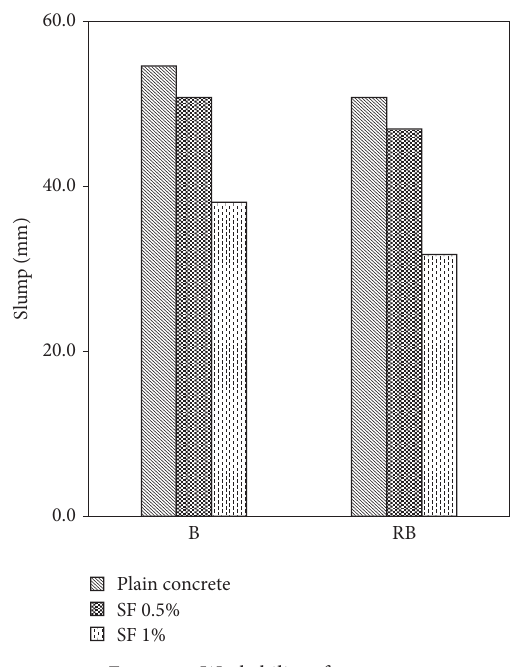
Figure 5: Workability of